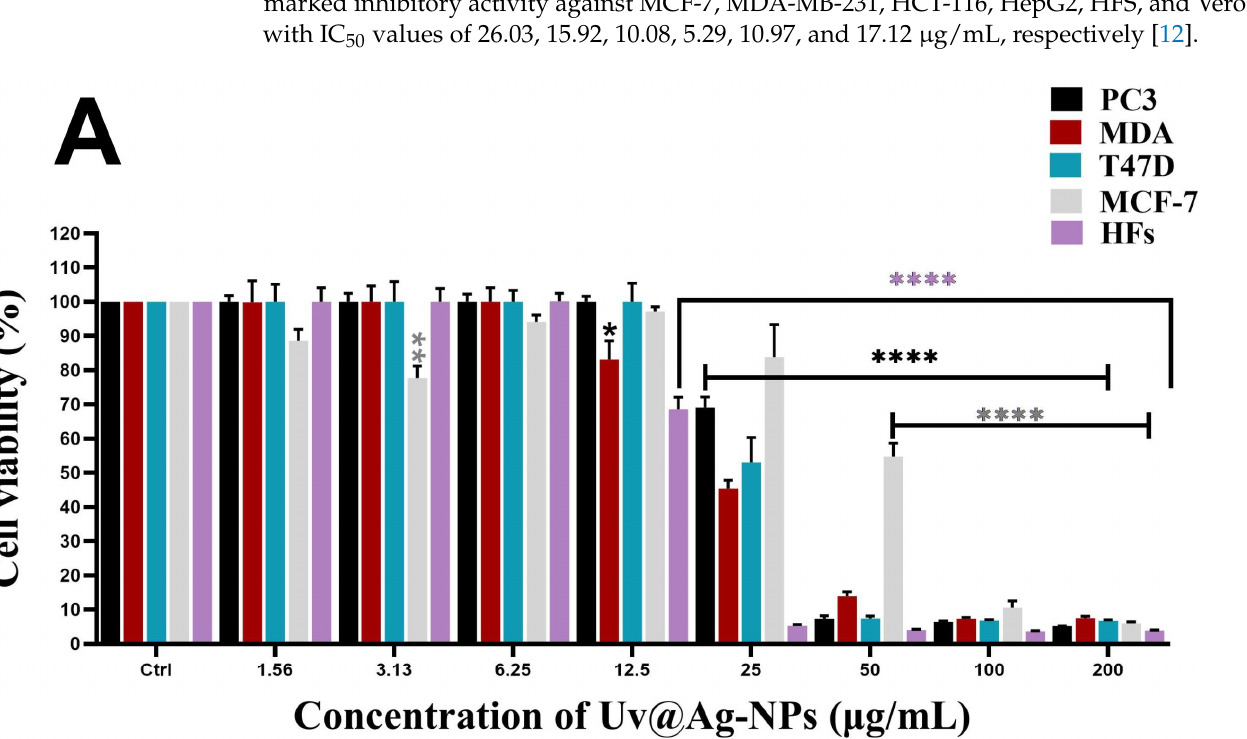
Figure 10. Antiproliferative activity ( A , B ) of a twofold serial dilution of 200 μ g/mL of Uv@Ag ‐ NPs synthesised from the unicellular ulvophyte sp. MBIC10591 against four malignant cells, PC3, MDA ‐ MB ‐ 231, T47D, and MCF ‐ 7, and normal cells, HFs. Data are represented as mean ± SEM. p ‐ values were calculated versus untreated cells: **** p < 0.0001, ** p < 0.001, and * p < 0.01.